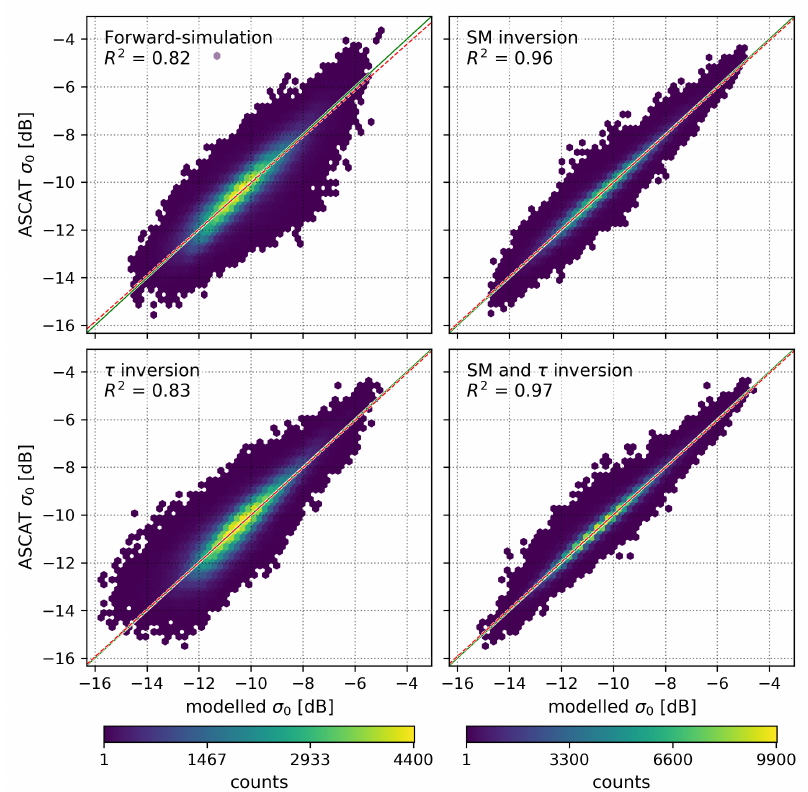
[ 0.25,0.55 ] ). The arrow indicates the site ∈